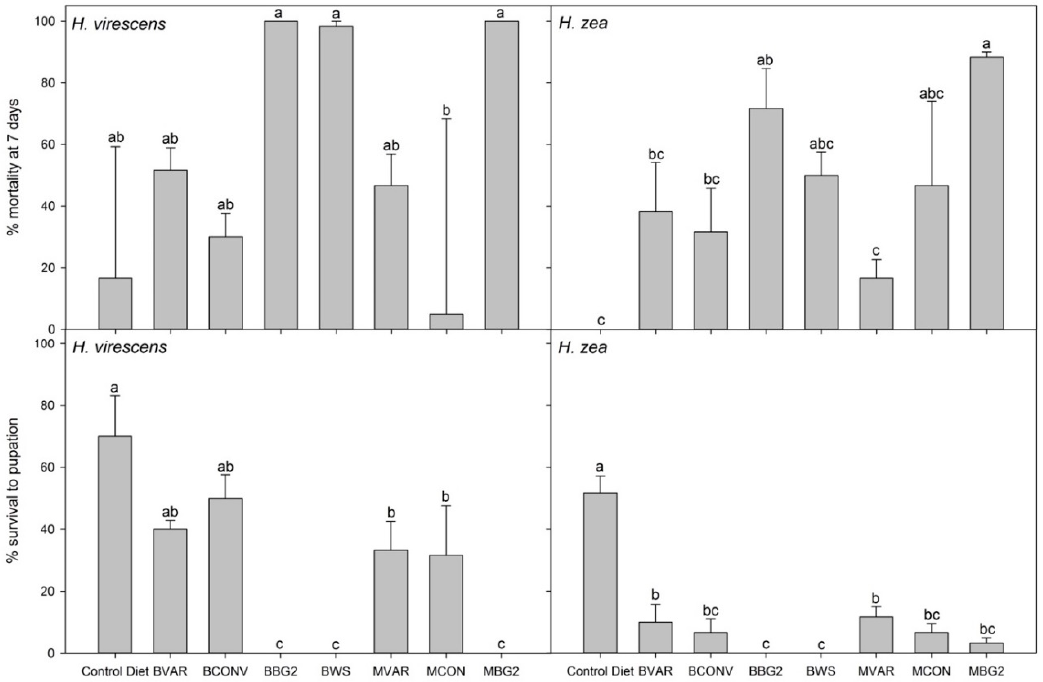
Figure 6. Mortality of H. virescens and H. zea larvae fed upper terminal leaves from different Bt and non-Bt cotton varieties for seven days, and subsequent survival to pupation. Bars (± SEM) with no common letters within an individual graph differ significantly (LSD, p = 0.05).